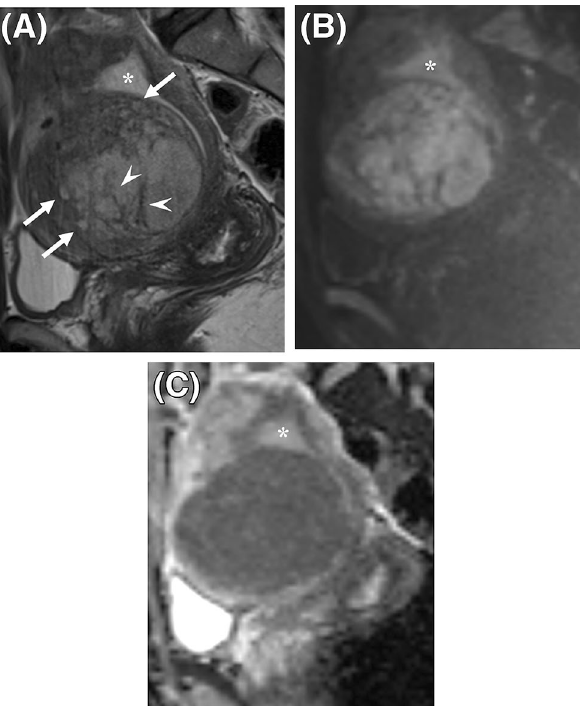
Figure 1. A representative case of low grade endometrial stromal sarcoma, showing worm-like nodular extension ( A , arrows) and intra-tumoral low signal intensity (SI) bands ( A , arrowheads) on T2-weighted images. The tumor shows high SI on diffusion-weighted images ( B ) with low apparent diffusion coefficient values ( C ). Asterisks were placed on endometrium ( A–C ).